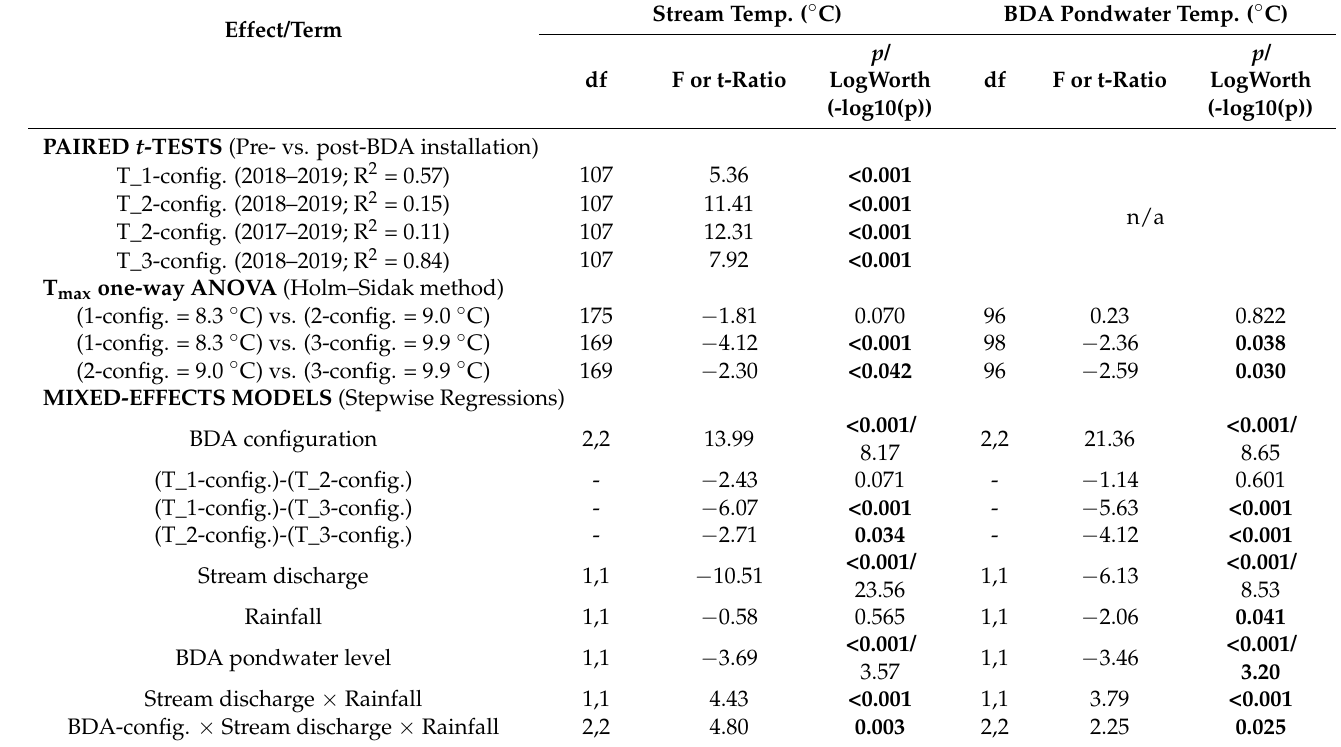
Table 1. Statistical analyses results of (1) paired t-comparisons between pre- and post-BDA treatment stream temperatures, (2) One-way analyses of variance (ANOVAs) for daily pond mean maximum temperatures (Tmax), and (3) two mixed-effects models with fixed effects of BDA configuration (single, double, triple), stream discharge, rainfall and BDA pond level, a random effect of BDA configuration, and an outcome variable of stream or pond temperature, over the 2017–2019 study periods †.